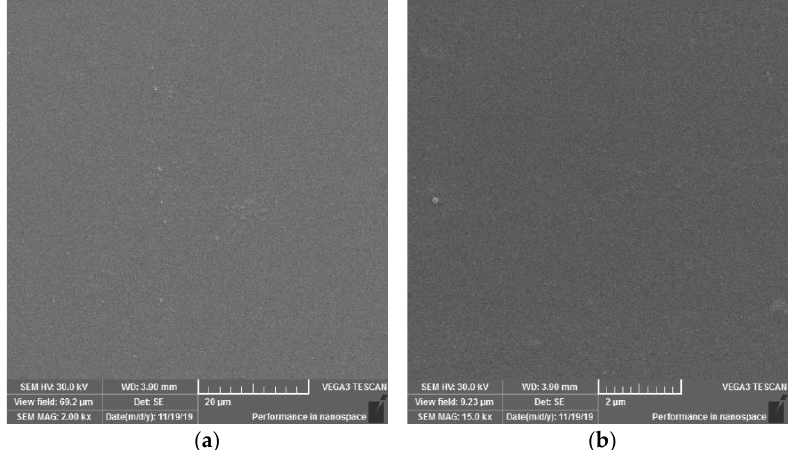
Figure 11. SEM morphology of the surface of unmodified PVC. Observed magnifications: 2000× ( a ) and 15,000× ( b ).